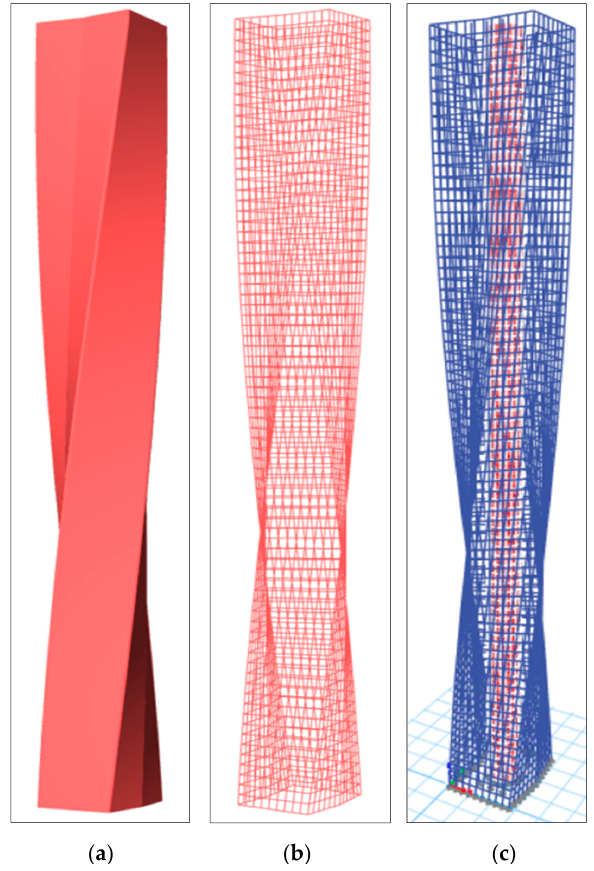
Figure 10. ( a ) Bluff model, ( b ) parametrical model, ( c ) structural Model.